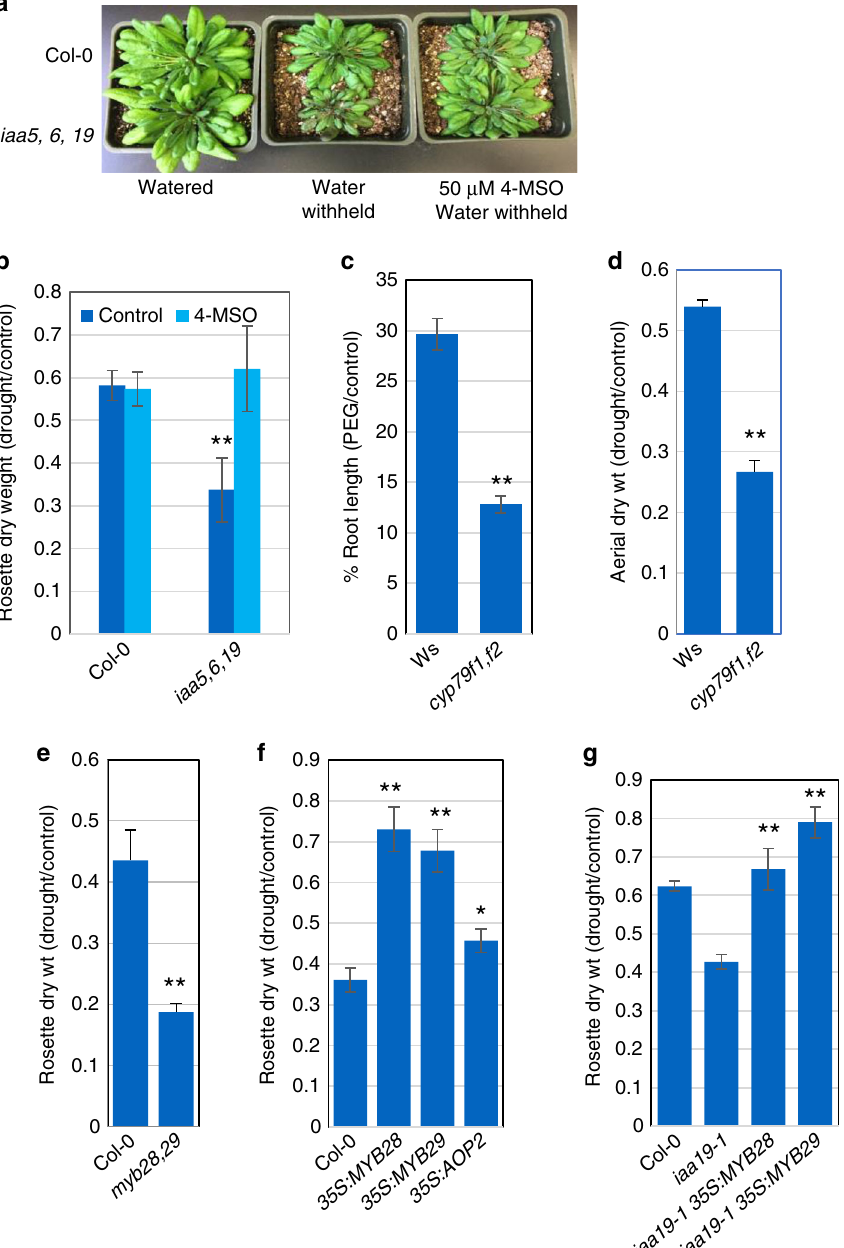
Fig. 2 Aliphatic glucosinolate de fi ciency is linked to decreased drought tolerance. a The iaa5,6,19 triple mutant is less drought tolerant than the wild type in a water withholding experiment. b Quanti fi cation of rosette dry weight from a . c cyp79f1,f2 double mutants are sensitive to growth on medium containing PEG compared to the wild-type Ws line. Results are presented as the mean ± SE of one experiments with n = 12 – 15 independent seedlings. d The cyp79f1,f2 line is less drought tolerant than Ws upon water withholding. e The myb28,29 double mutant is less drought tolerant compared to the wild type. f 35 S: MYB28 , 35 S:MYB29 and 35 S:AOP2 plants display increase drought tolerance. g Overexpression of MYB28 or MYB29 restores drought tolerance to iaa19-1 plants. Results are presented as the means± SE of one experiment with n = 10 independent pots. Each experiment was repeated at least twice. For b – g , differences between mutants and Col-0 or Ws are signi fi cant at p < 0.05 ( ∗ ) and p < 0.01 ( ∗∗ ) by two-tailed Student ’ s t test. Source data are provided as